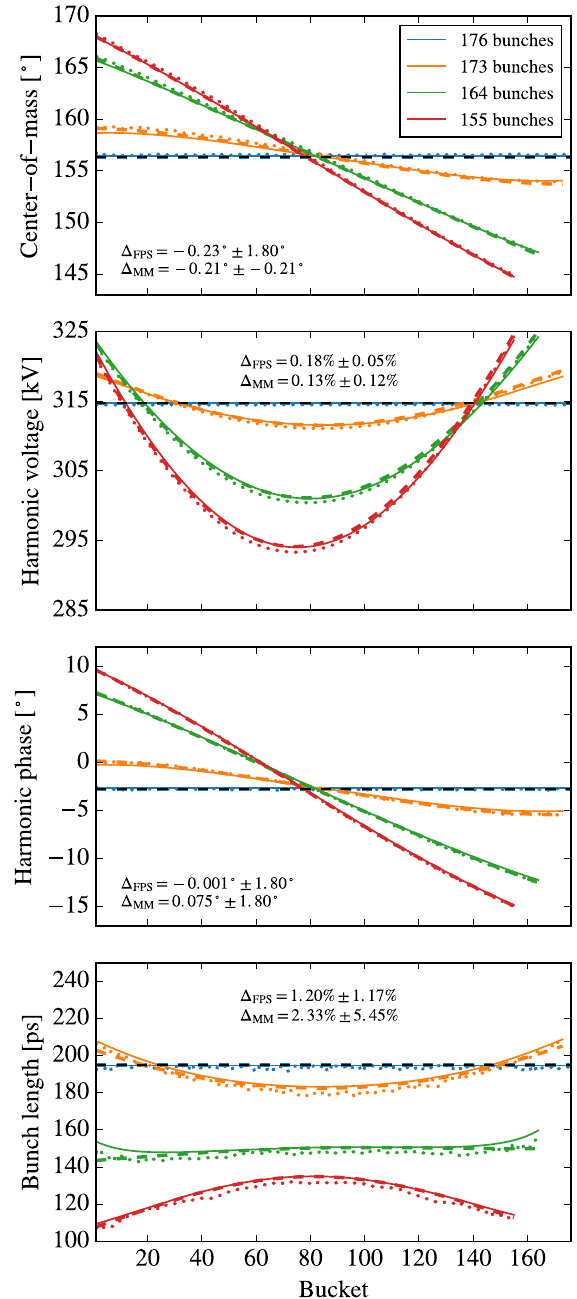
FIG. 6. Center-of-mass, harmonic field and bunch length for different gaps including complex form factor for the matrix formulation (solid) and F ILL P ATTERN S IM (dashed). The MBTRACK results (dotted) and the analytical values for a uniform fill pattern (black dashed) are shown for comparison. The mean and RMS of the deviations from the MBTRACK results are displayed for the case with 164